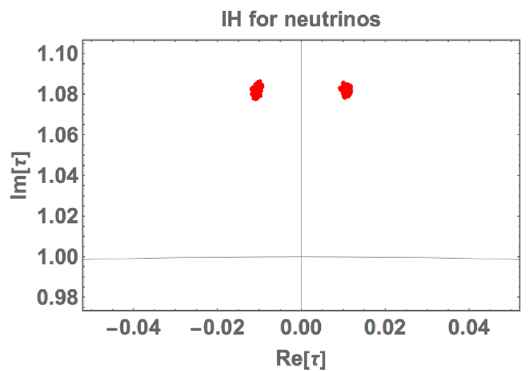
Figure 8 . The allowed region of g ν which are real parameters, for